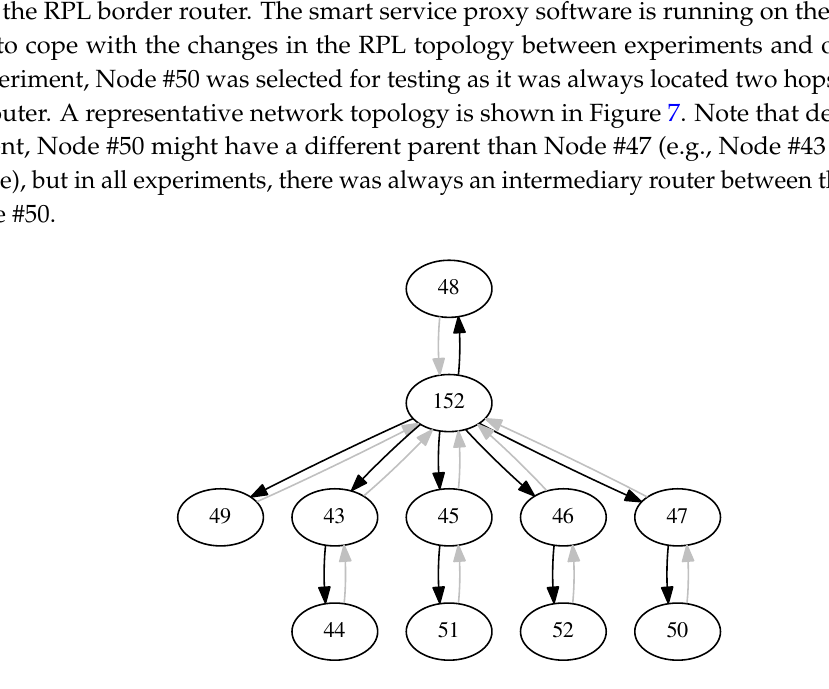
Figure 7. Representative RPL network topology: the node under study, Node #50, is situated two hops from the border router, Node